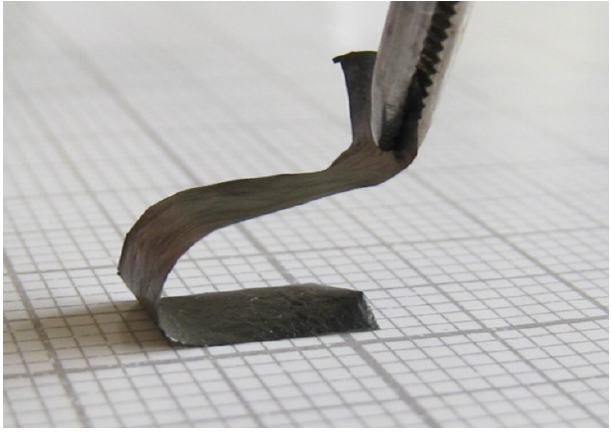
Figure 8. Photo-image of the erGO/PAn composite film.